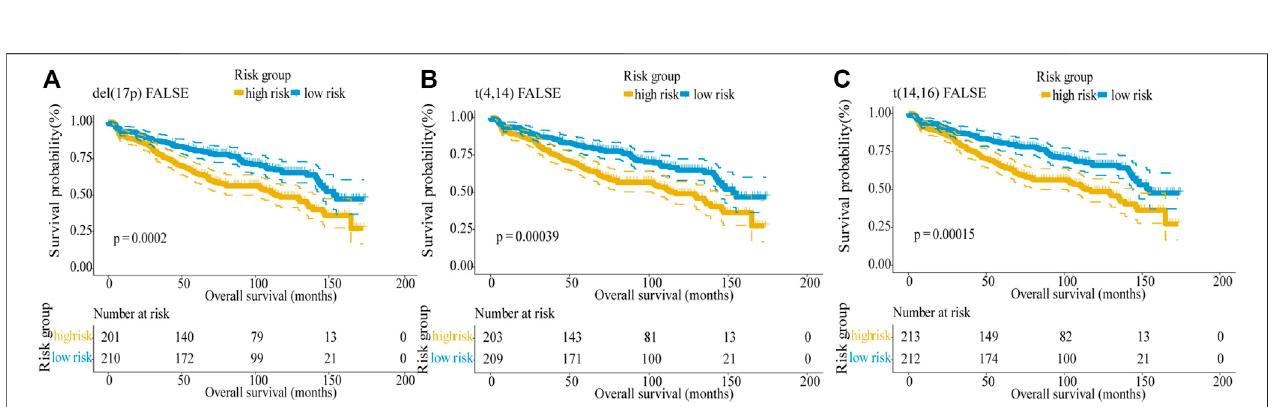
FIGURE 6 | Validation of the fi ve-gene risk score model in patients without genetic risk indicators by Kaplan – Meier curves. (A) MM patients without del (17p) ( p (cid:1) 0.0002). (B) MMpatientswithoutt(4,14)( p (cid:1) 0.00039). (C) MMpatientswithoutt(14,16)( p (cid:1) 0.00015).MMpatientsweredividedintohigh-riskandlow-riskgroups by the median risk